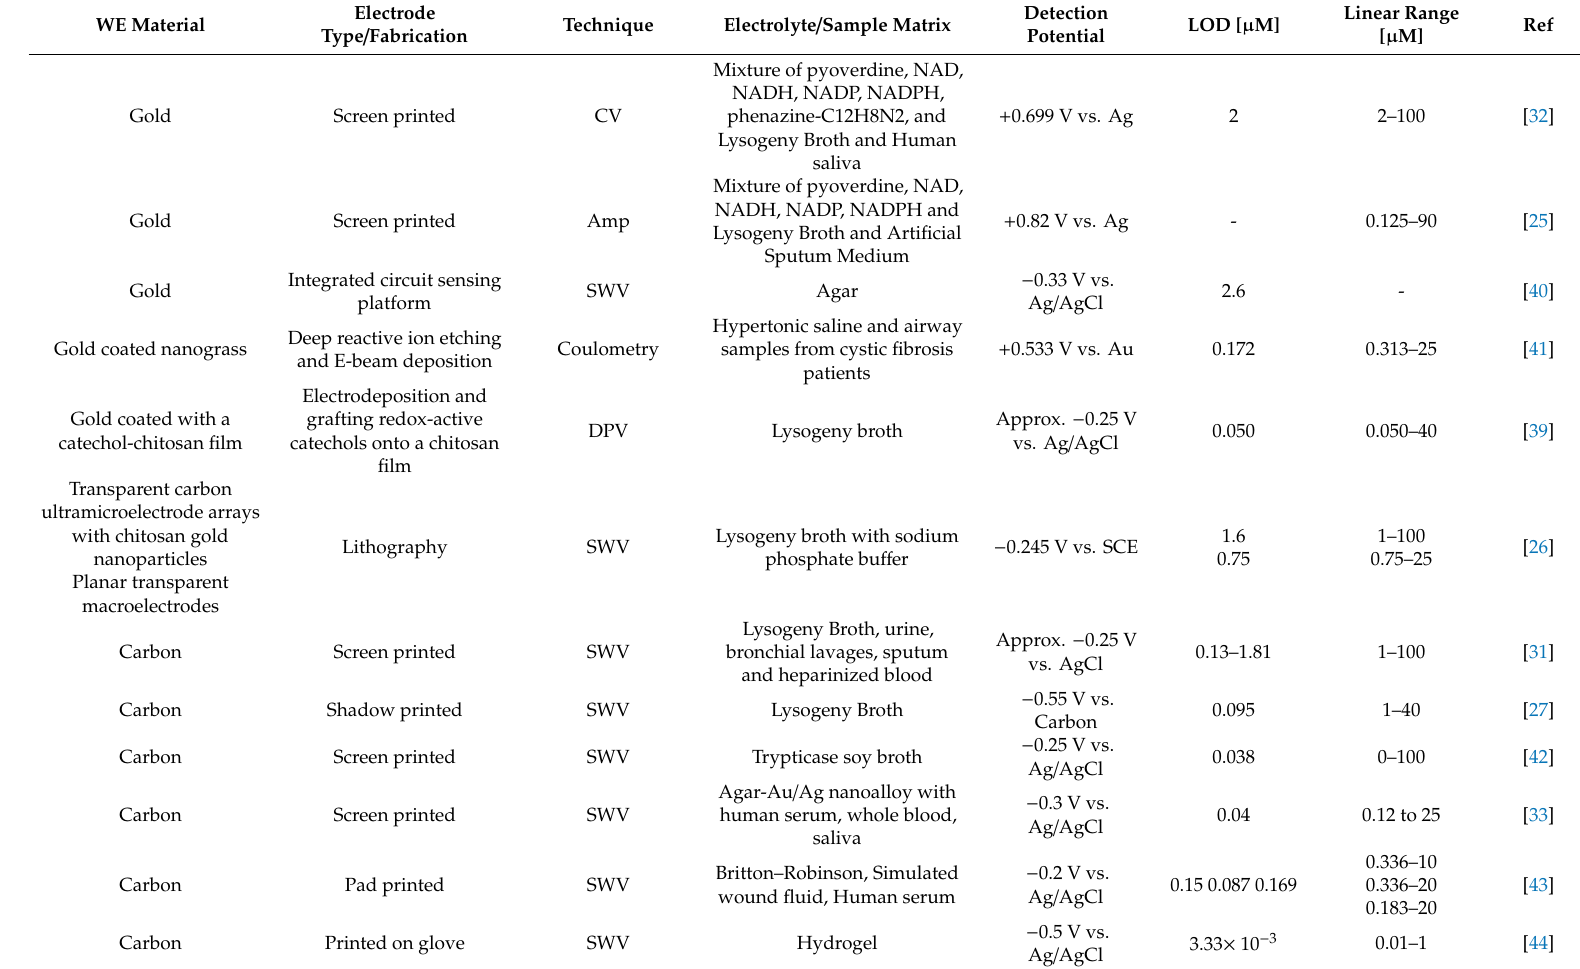
Table 1. Overview of reports on electrochemical methods for the determination of